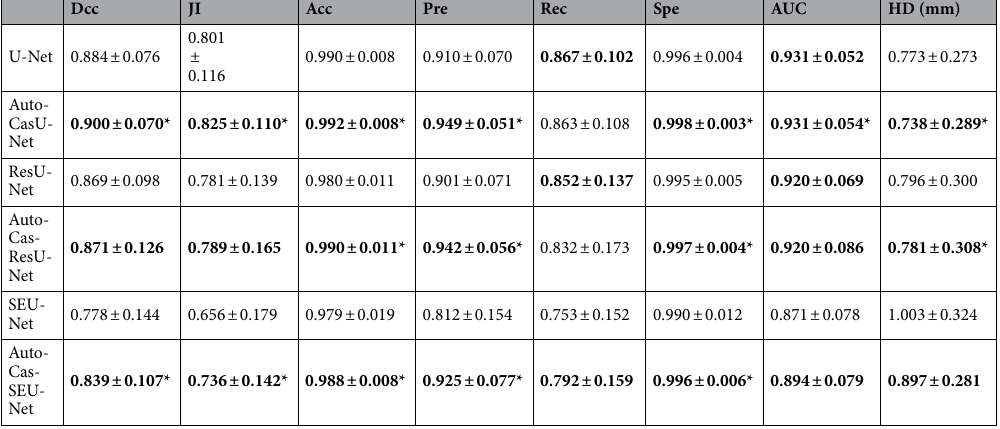
Table 1. Quantitative inner ear segmentation results based on Dice coefficient (Dcc), Jaccard index (JI), accuracy (Acc), precision (Pre), recall (Rec), specificity (Spe), area under ROC curve (AUC) and Hausdorff distance (HD). The results for the baseline networks are for axial viewpoints (0.2–1.1% better average dice coefficient performances obtained from this view compared to coronal or sagittal orientations; data not shown). The best metrics for each comparison are shown in bold. The results are an average of the 17 3D μCT volumes. * p < 0.05, Wilcoxon signed-rank